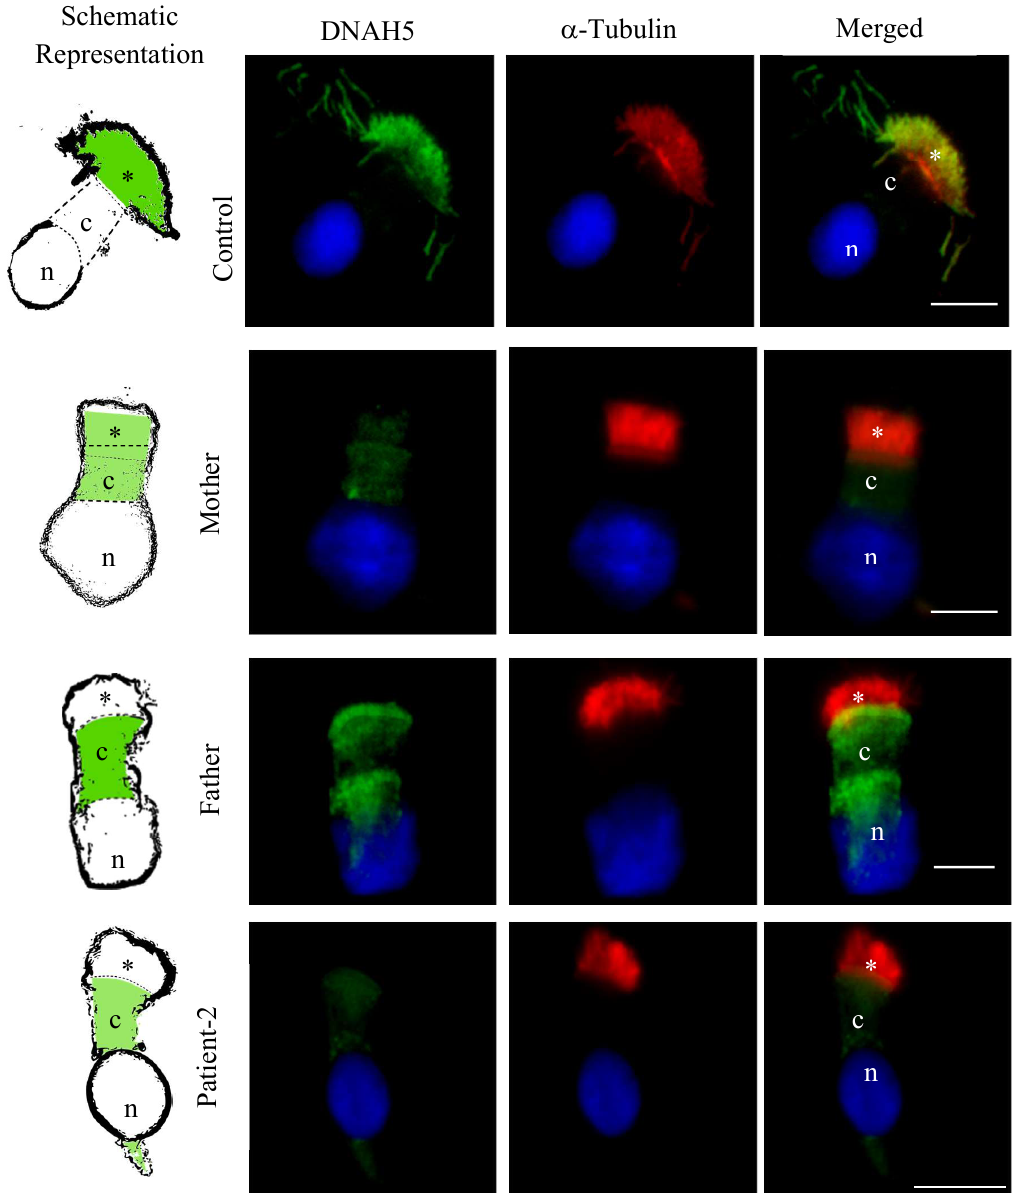
Figure 5. Expression and localization of specific DNAH5 protein by immunofluorescence in respiratory epithelial cells from healthy volunteers (Control), both parents of Patient-2 (Mother and Father) and Patient-2. Staining with anti-DNAH5 antibodies (green) and with antibodies against axoneme-specific acetylated -tubulin (red). Nuclei stained with DAPI (blue). Schematic representation at left to better localize the staining (DNAH5 in intense or faint green). * = cilia; c = cytoplasm; n = nuclei. Scale bars = 10 µm.